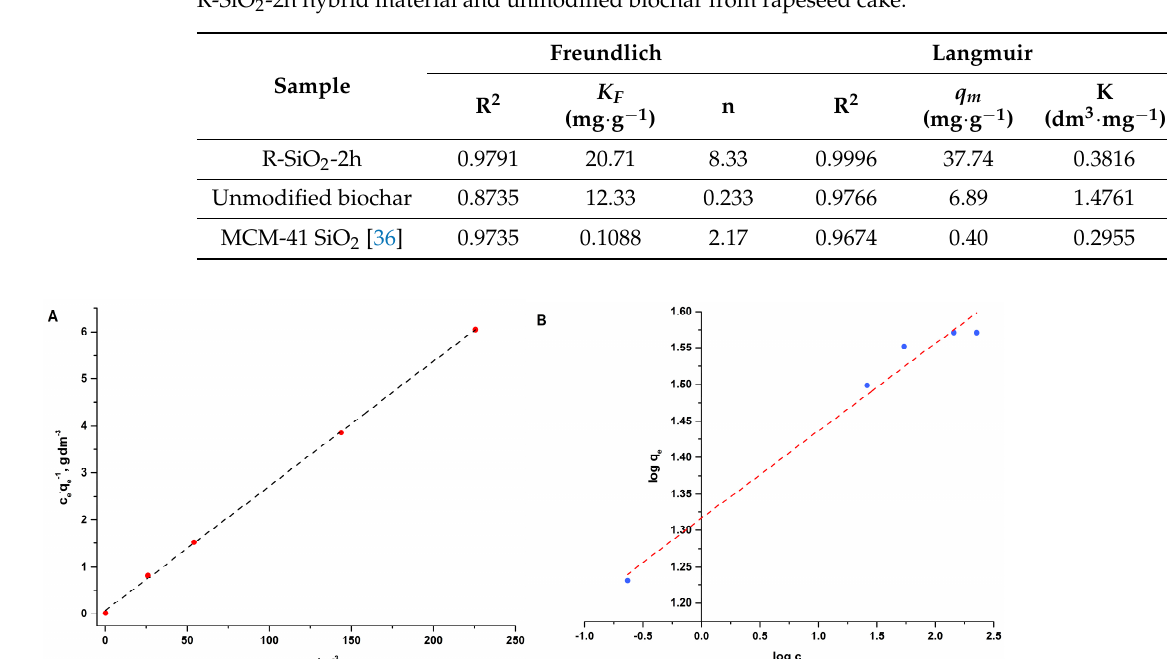
Figure 9. Linear form of Langmuir ( A ) and Freundlich ( B ) isotherms for adsorption of copper(II) ions onto R-SiO 2 -2h hybrid material. Table 4. Freundlich and Langmuir isotherms parameters for adsorption of copper(II) ions onto R- SiO 2 -2h hybrid material and unmodified biochar from rapeseed cake.